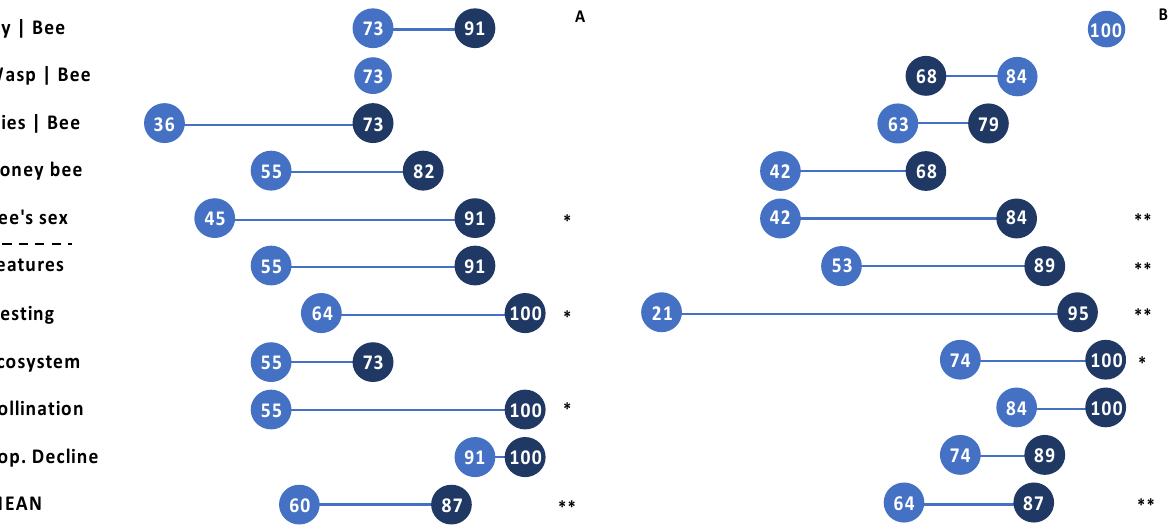
Figure 1. Performance-based Knowledge Gains-Test. Mean proportion (%) of correct pre- and post-course test scores per question across all participants in ( A ) 2018 and ( B ) 2019. The dotted line separates the first five questions focused on Identification Skills from the remaining five questions focused on Ecological Knowledge. * p < 0.05, ** p < 0.01 indicates statistically significant differences between pre (light) and post (dark) scores (see Supplementary Tables S2 and S3).